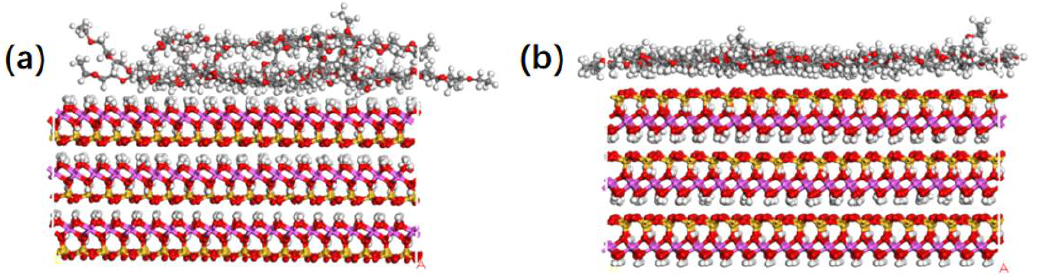
Figure 12. Spatial equilibrium structure of PEO adsorption on ( a ) Kaolinite 001 surface and ( b ) Ka- olinite 00 1̅ surface.